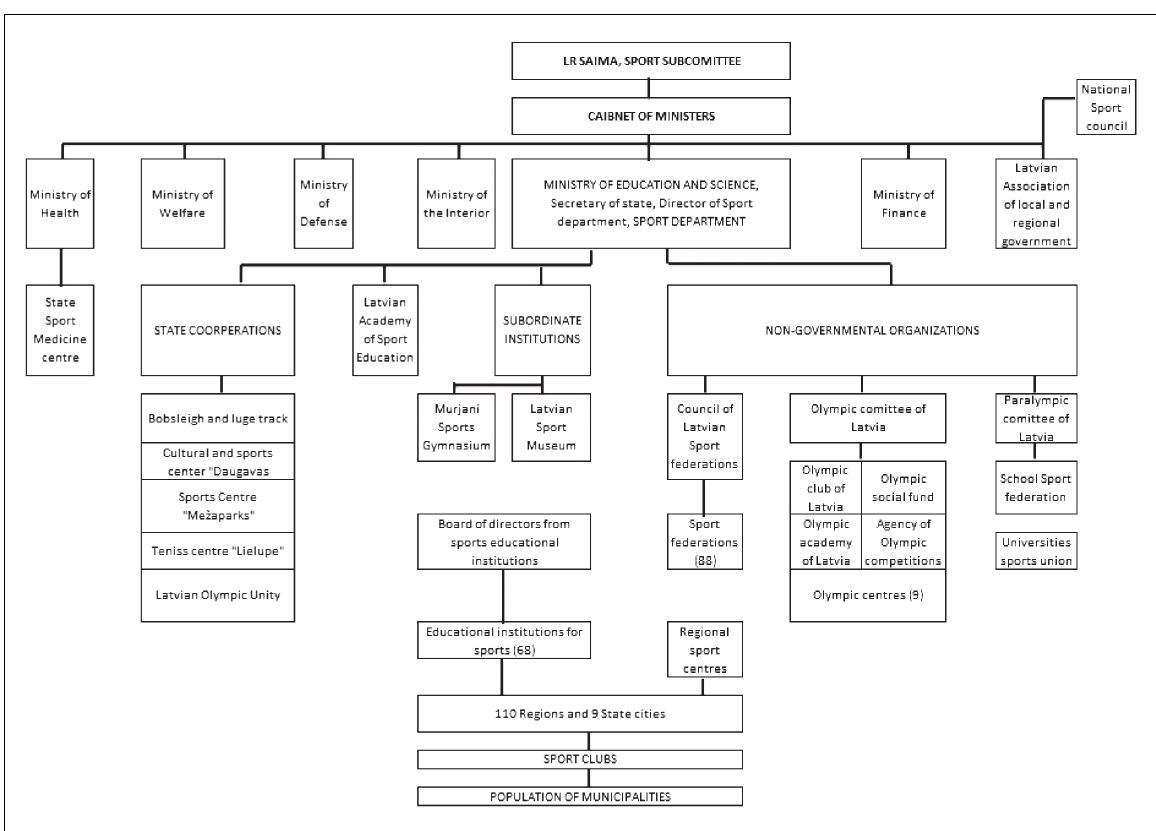
Figure 1. Sports industry structure and funding professional hockey players per number of youth